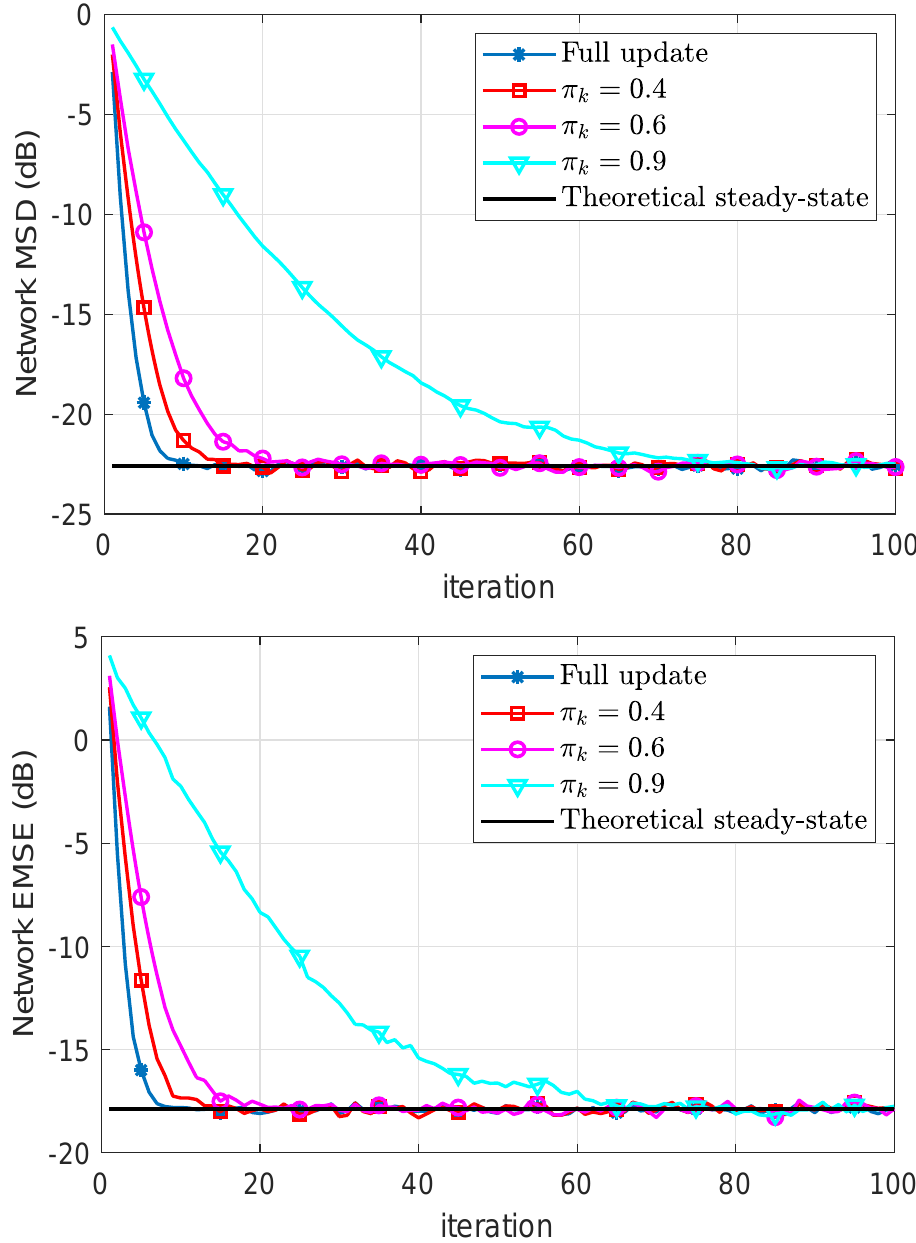
Figure 4. Simulated network MSD and EMSE curves and their theoretical results. In Figure 5, we demonstrate the experimental and theoretical steady-state MSDs and EMSEs for π k = 0.6. It can be seen that, the calculated steady-state MSD and EMSE values using the theoretical expressions in (47) and (48) have a good agreement between with those obtained by the simulation